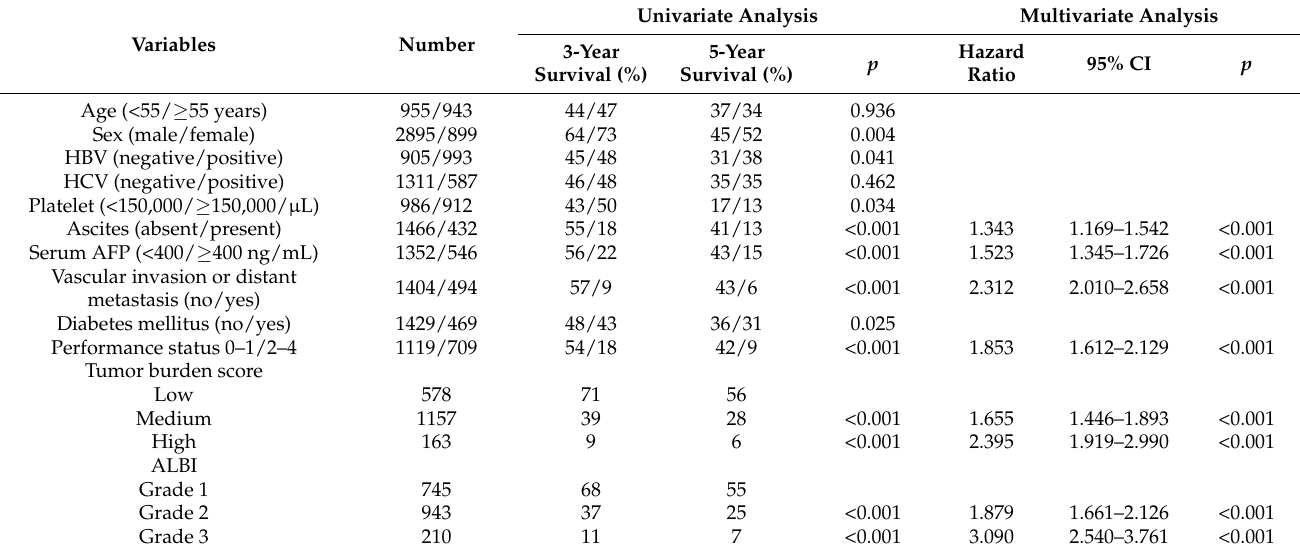
Table 2. Univariate and multivariate analysis of overall survival in HCC patients in the derivation cohort ( n =